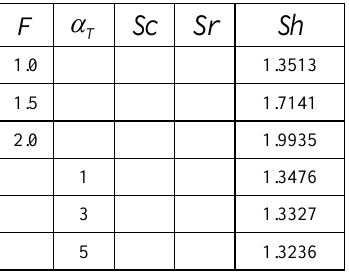
Table 3. Effect of various physical parameters on Sherwood number ()